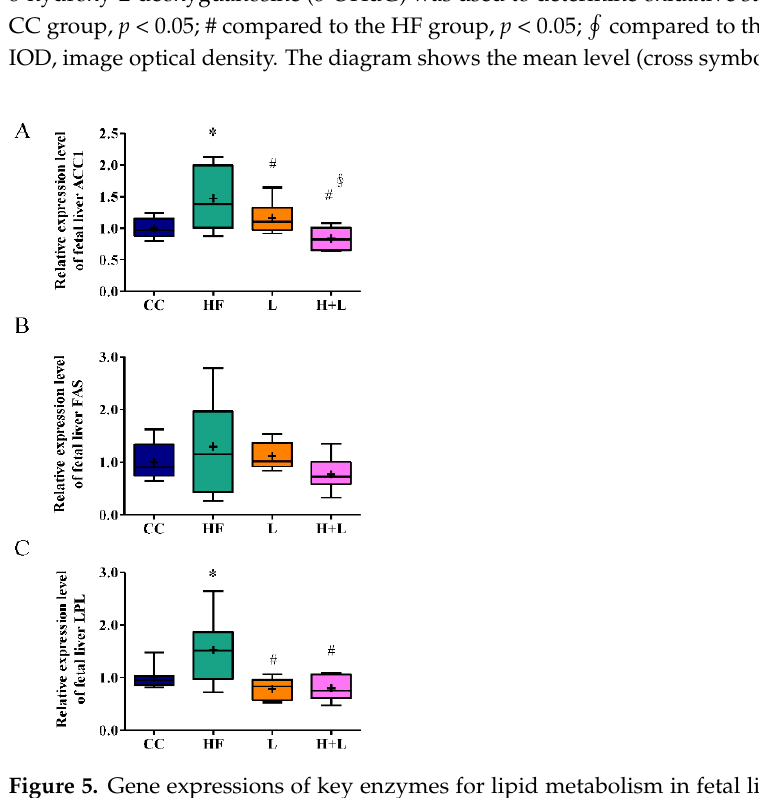
Figure 5. Gene expressions of key enzymes for lipid metabolism in fetal liver. ( A ) ACC1 ( B ) FAS ( C ) LPL mRNA expressions in the fetal liver with a maternal control diet (CC), a maternal